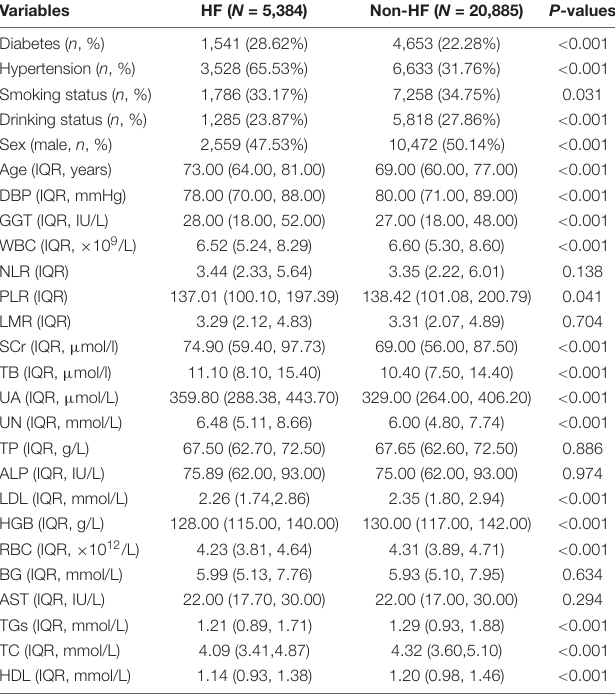
Frontiers in Cardiovascular Medicine |